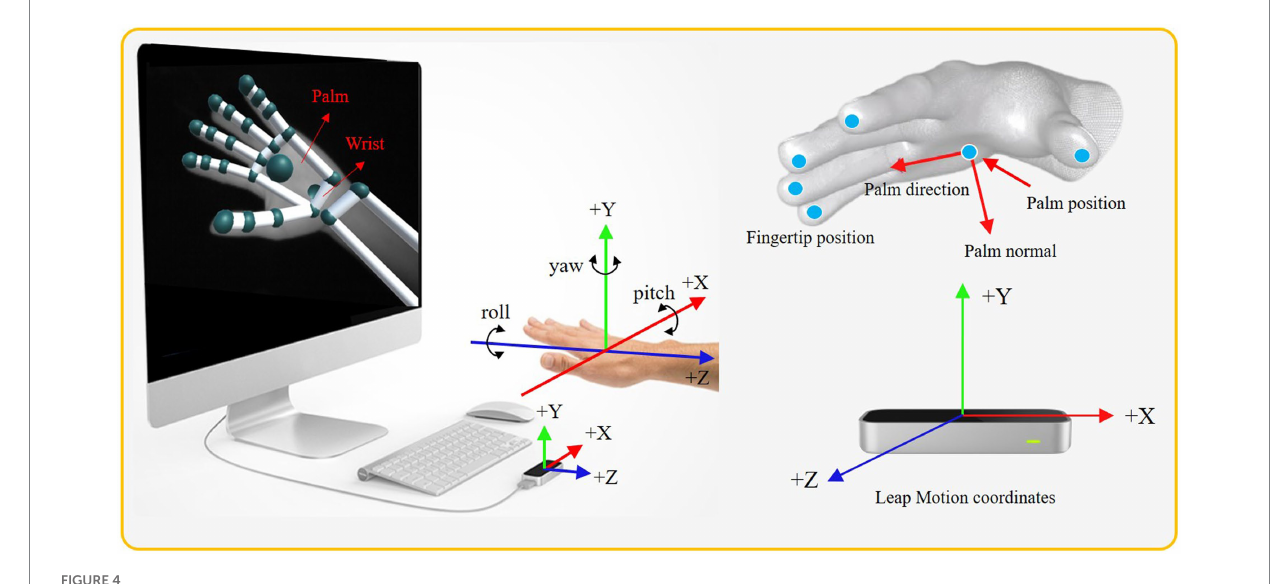
FIGURE 4 The coordinate system of the Leap Motion sensor and diagram of the bone data detected by it.